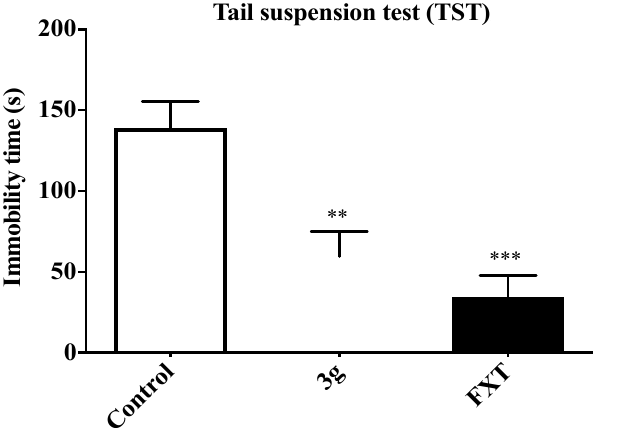
Figure 4. Effects of compound 3g and FXT (i.p., 50 mg/kg) on the duration of immobility time in the TST. Ten animals were used for each group. ** p < 0.01 compared to the control group, *** p < 0.001 compared to the control group.